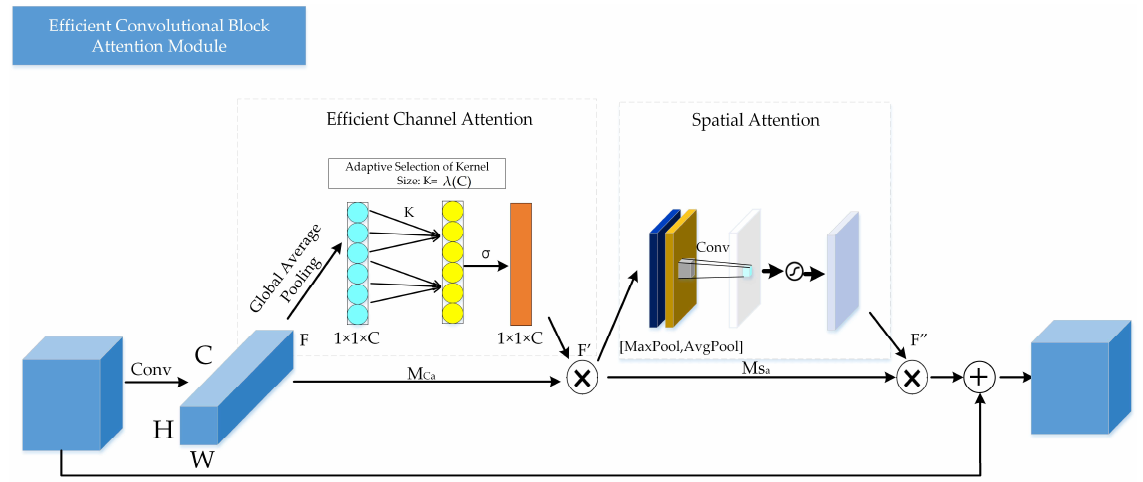
Figure 2. Schematic diagram of the efficient convolutional block attention module (ECBAM).